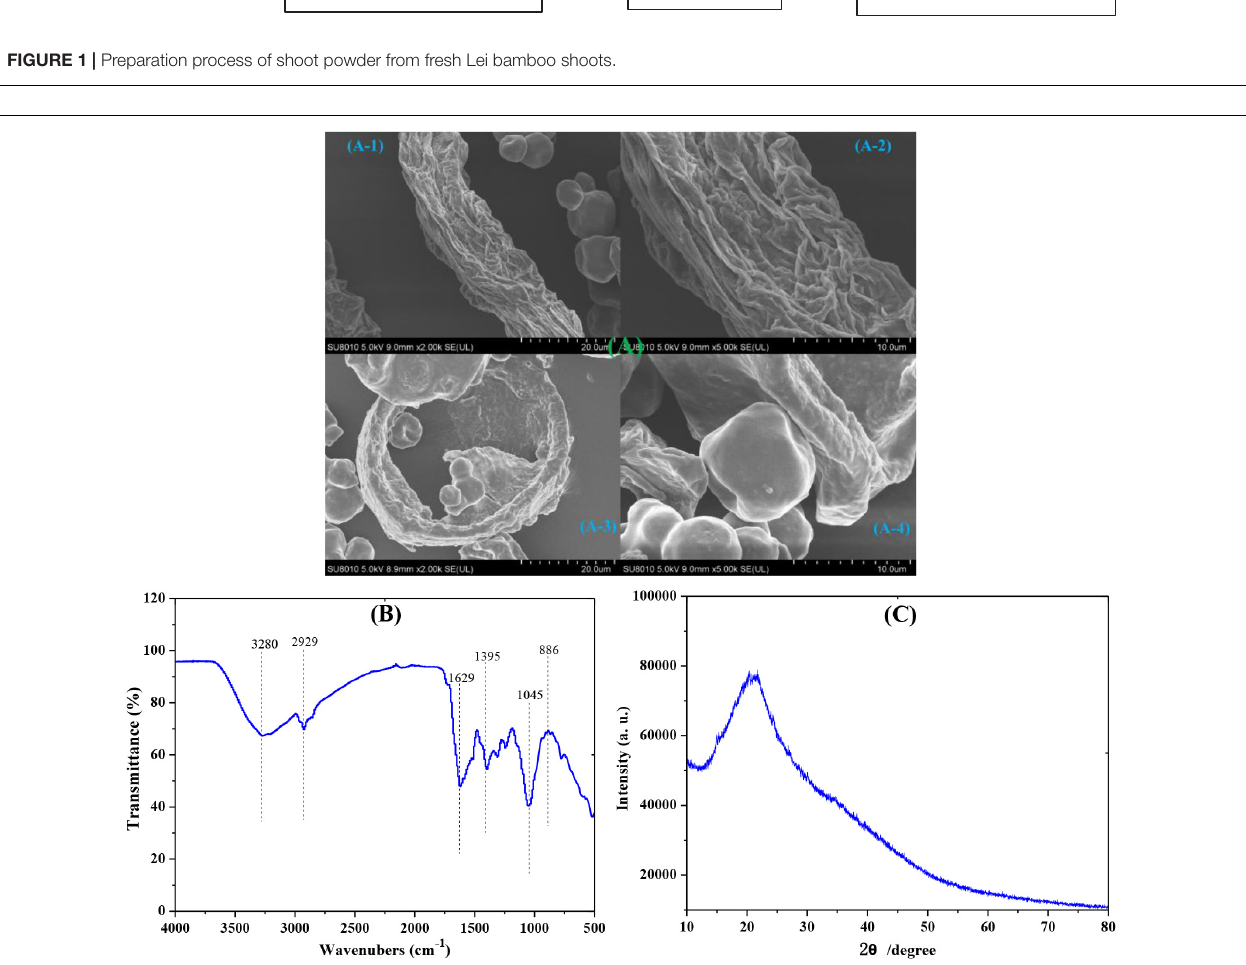
FIGURE 2 | SEM (A) , IR (B) , and XRD (C) of bamboo shoot